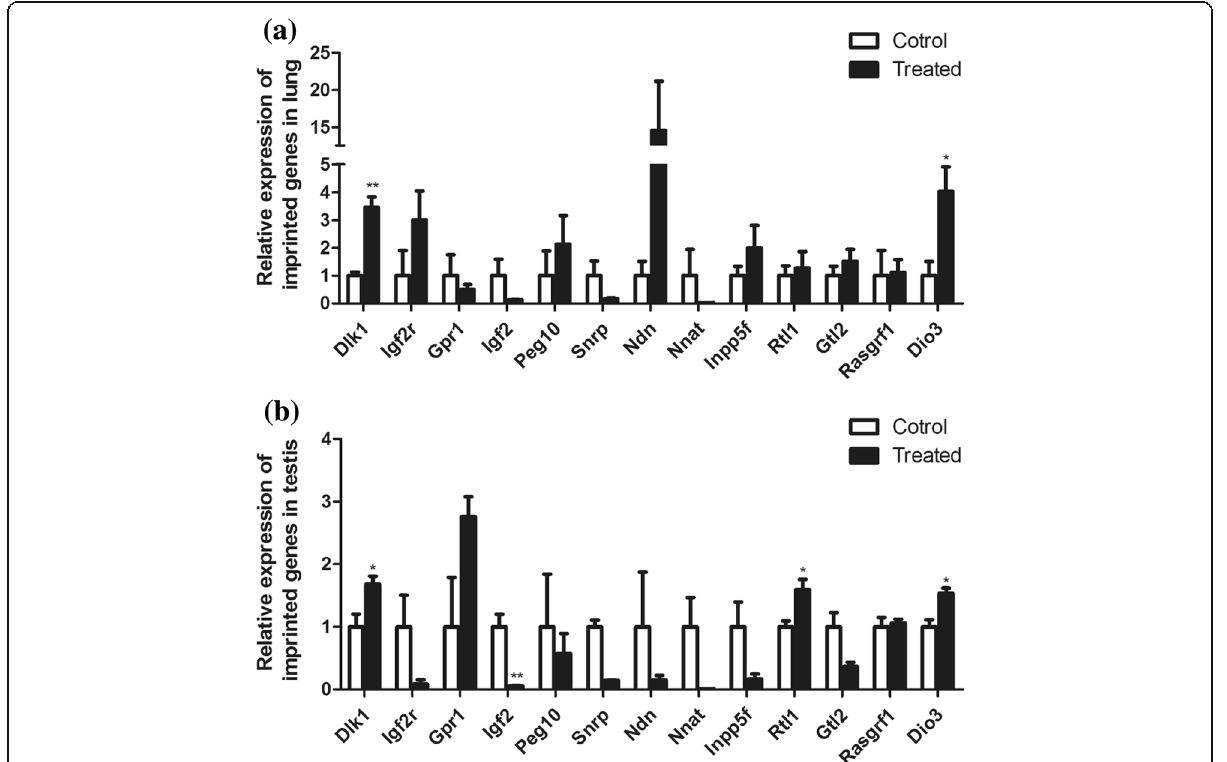
Fig. 3 Expression of imprinted genes in lung and testis. a The expression of imprinted genes in lung. b The expression of imprinted genes in